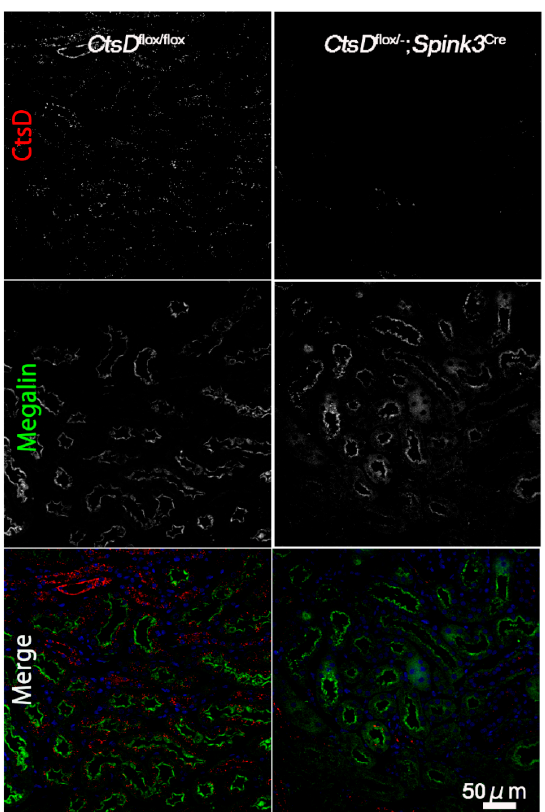
Figure 1. Cathepsin D is depleted in renal tubular cells in the cortico-medullary region of CtsD flox/ − ; Spink3 Cre mouse. Representative images of cathepsin D ( CtsD ) staining in the cortico-medullary region of CtsD flox/flox and CtsD flox/ − ; Spink3 Cre mouse kidneys. Megalin was employed as a marker of proximal tubules. In the merged images (Merge), CtsD was pseudo-colored red, Megalin was green, and 4',6-diamidino-2-phenylindole (DAPI) was blue. Please note that in the CtsD flox/ − ; Spink3 Cre mouse, cathepsin D was significantly depleted in most of the renal proximal tubular epithelial cells. Bar, 50 µ m.